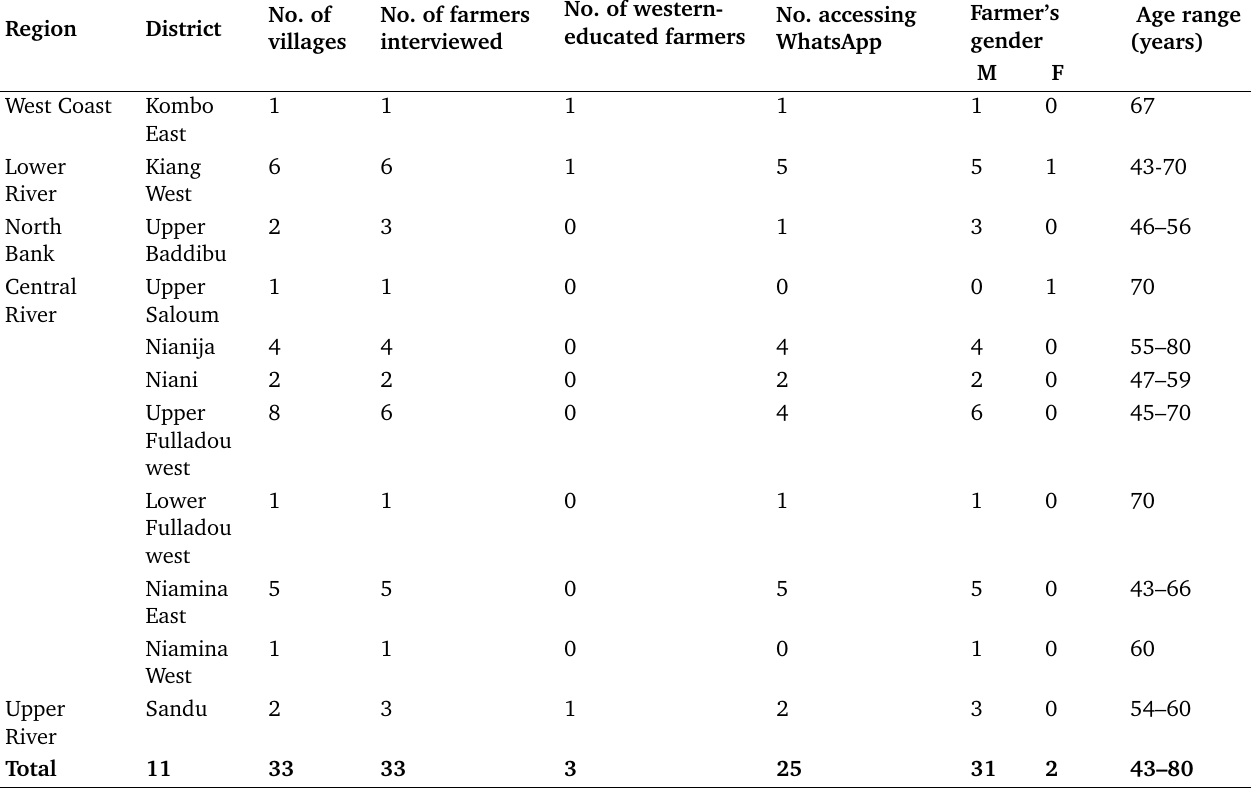
Table 1. Profile of the 33 interviewed Multiplier tier farmers